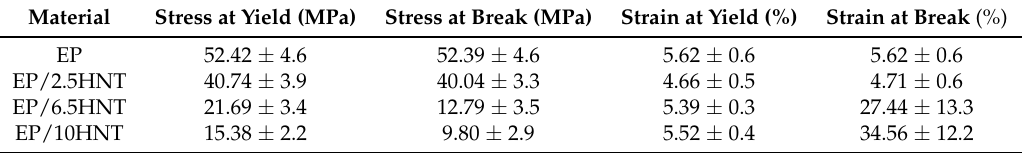
Table 3. Summary of the main parameters derived from the tensile tests of the EP resin and EP/HNTs.